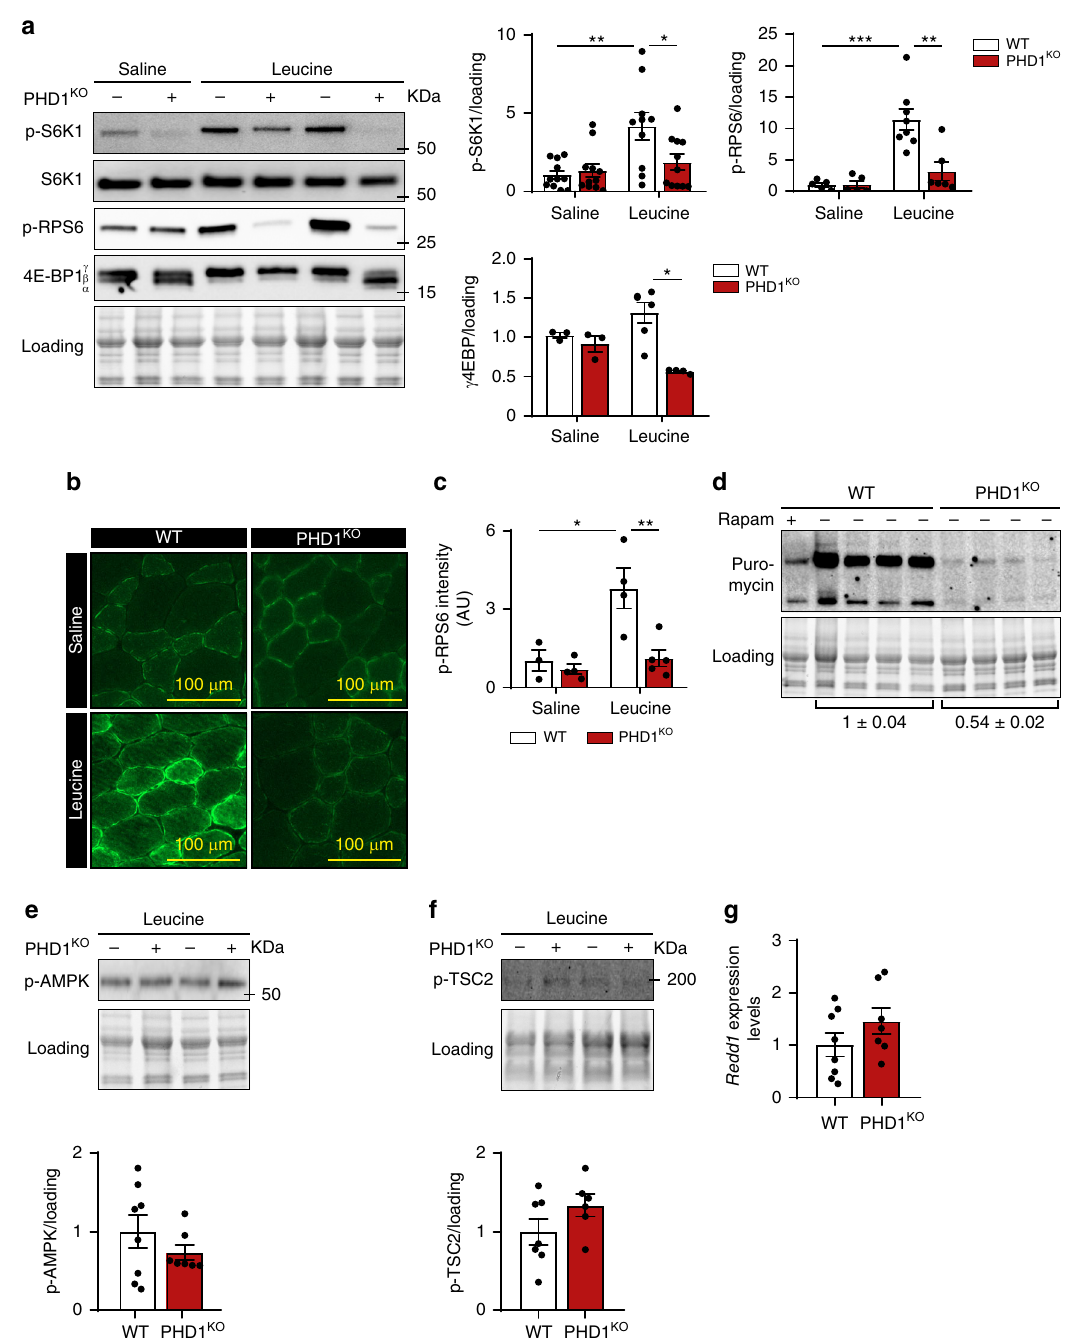
Fig. 2 PHD1 is required for leucine-mediated mTORC1 activation in vivo. a Representative pictures (left panel) and quanti fi cation (right panels) of western blot analysis of S6K1, RPS6, and 4E-BP1 phosphorylation in TA muscles from WT (white bars) and PHD1 KO (red bars) female mice 30 min after saline or leucine gavage. Representative pictures b and quanti fi cation c of p-RPS6 immuno fl uorescence analysis in TA muscle of WT (white bars) and PHD1 KO (red bars) mice 30 min after saline (saline) or leucine (leucine) gavage. Intensity measurements are provided in arbitrary units (AU). d Representative pictures and quanti fi cation of western blot analysis of puromycin incorporation in TA muscle from WT ( n = 4) and PHD1 KO male mice ( n = 4) 30 min after leucine gavage. Rapamycin (rapam) was used as a negative control. Representative pictures (top panel) and quanti fi cation (bottom panel) of western blot analysis of AMPK phosphorylation ( e ) and TSC2 phosphorylation ( f ) in TA muscle from WT (white bars) and PHD1 KO (red bars) mice 30 min after leucine gavage. g Redd1 mRNA expression levels in TA muscle from WT (white bars) and PHD1 KO (red bars) female mice. Statistics: two-way ANOVA test with a Holm – Sidak post hoc test ( a , c ) or unpaired t test ( e – g ) (* p < 0.05; ** p < 0.01; *** p < 0.001; ns not signi fi cant). Each dot represents a single mouse. Bar graphs represent mean ± SEM (error bars). Data are represented as fold change to WT saline ( a , c , e , f ) or fold change to WT ( g ). TA m. tibialis anterior . See also Supplementary Fig. 2. Source data are provided as a Source Data fi